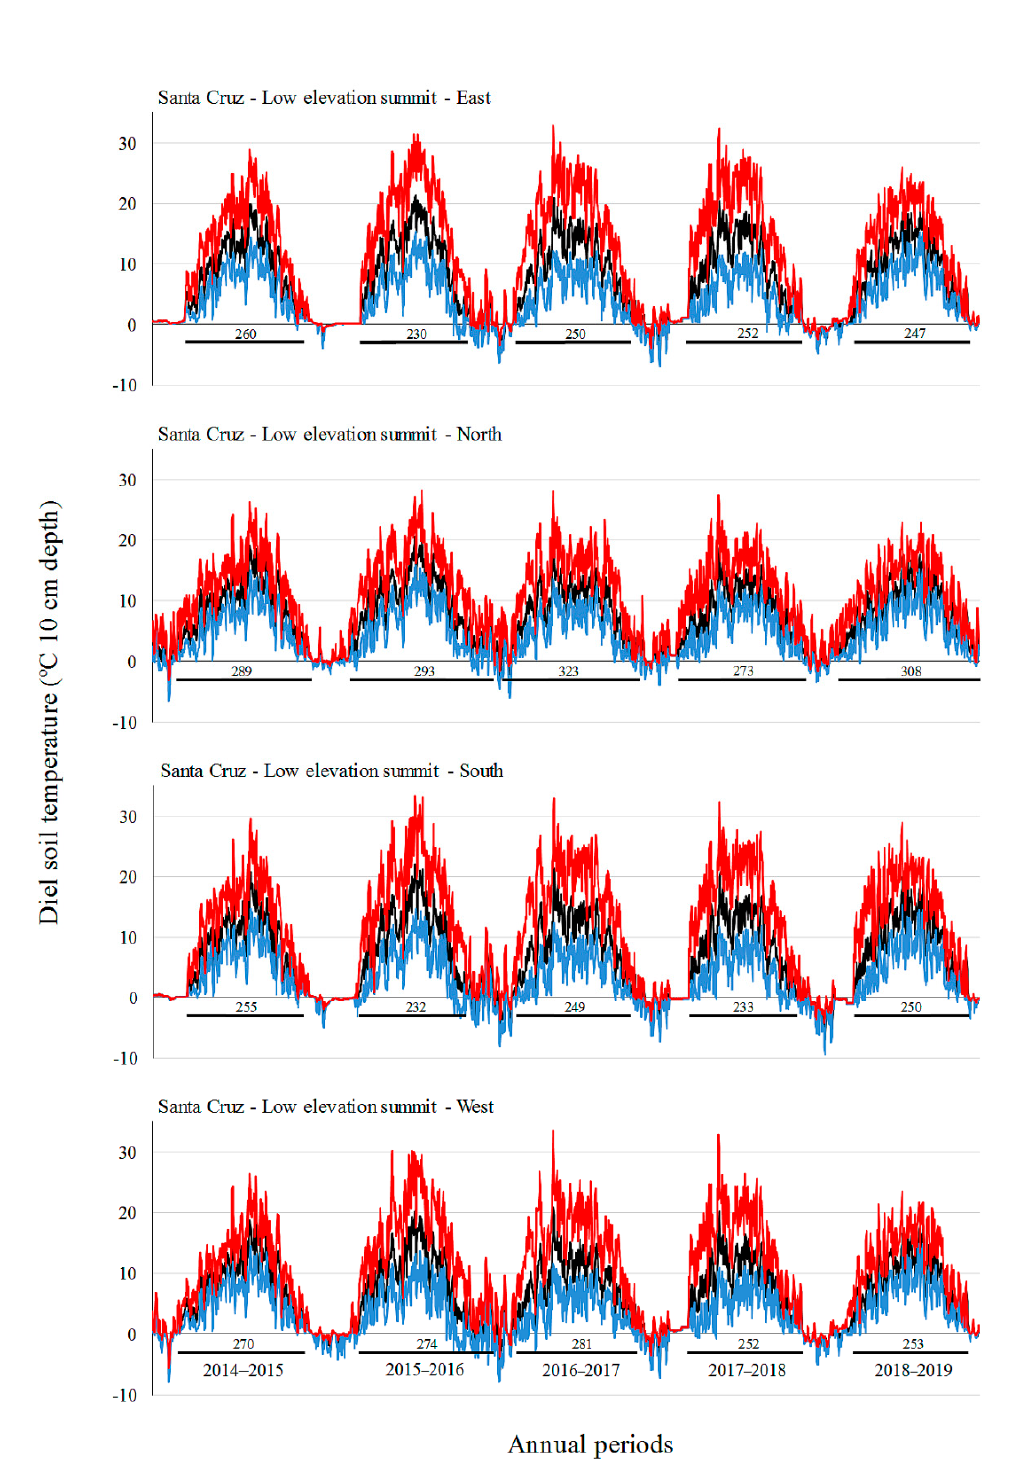
Figure A1. Diel soil temperature ( ◦ C) variation at 10 cm depth during the five studied annual periods (2014–2015 to 2018–2019) on low elevation summit in Santa Cruz, showing separately different cardinal aspects (east, north, south, west). The length of the growing season is also indicated with horizontal black bars (numbers represent days). Black = mean temperature; blue = minimum temperature, and red = maximum temperature.